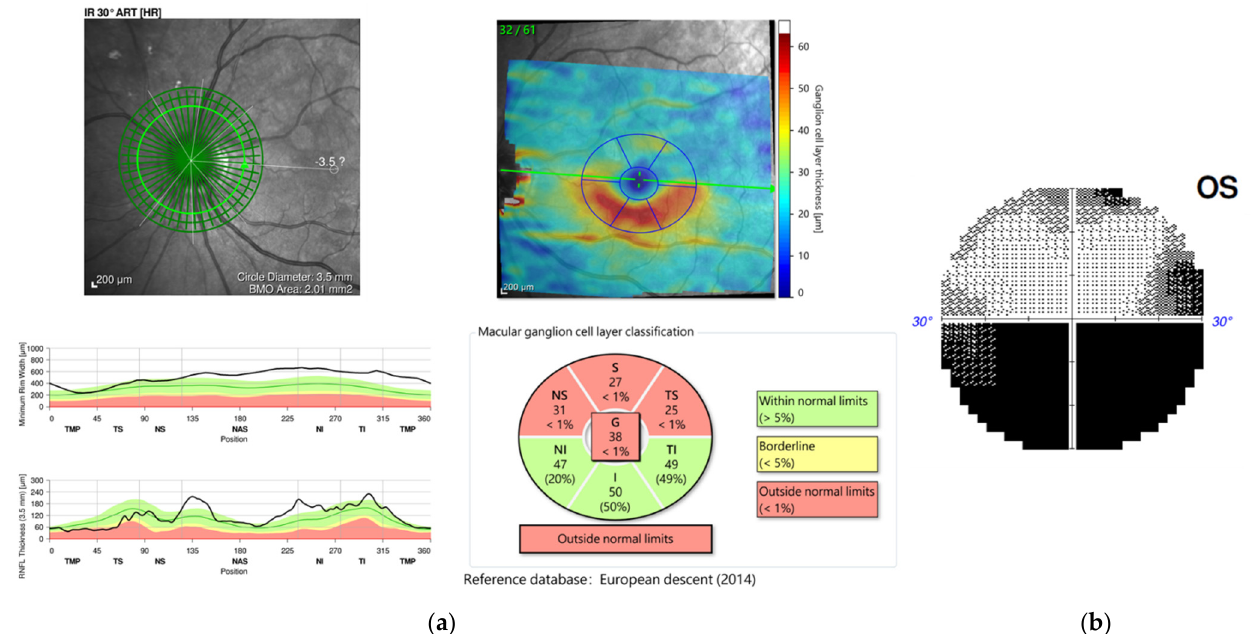
Figure 2. ( a ) Optical coherence tomography (OCT) showed peripapillary retinal nerve fiber layer (pRNFL) edema and thinning of the macular ganglion cell layer (GCL) in the superior hemisphere in the patient’s left eye, ( b ) corresponding to an inferior altitudinal visual